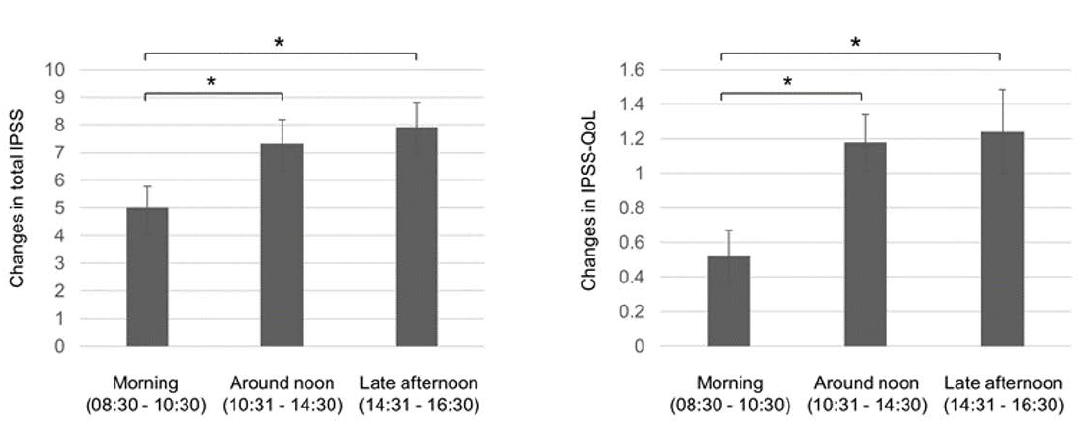
Figure 1. Differences in change of IPSS total score and IPSS-Quality of Life (QoL) score between pre- and post-proton beam therapy by time of day for radiation. IPSS, international prostate symptom score; Quality of Life (QoL). * p < 0.05 by the Dunnett test as a post-hoc analysis for multiple linear regression analysis.